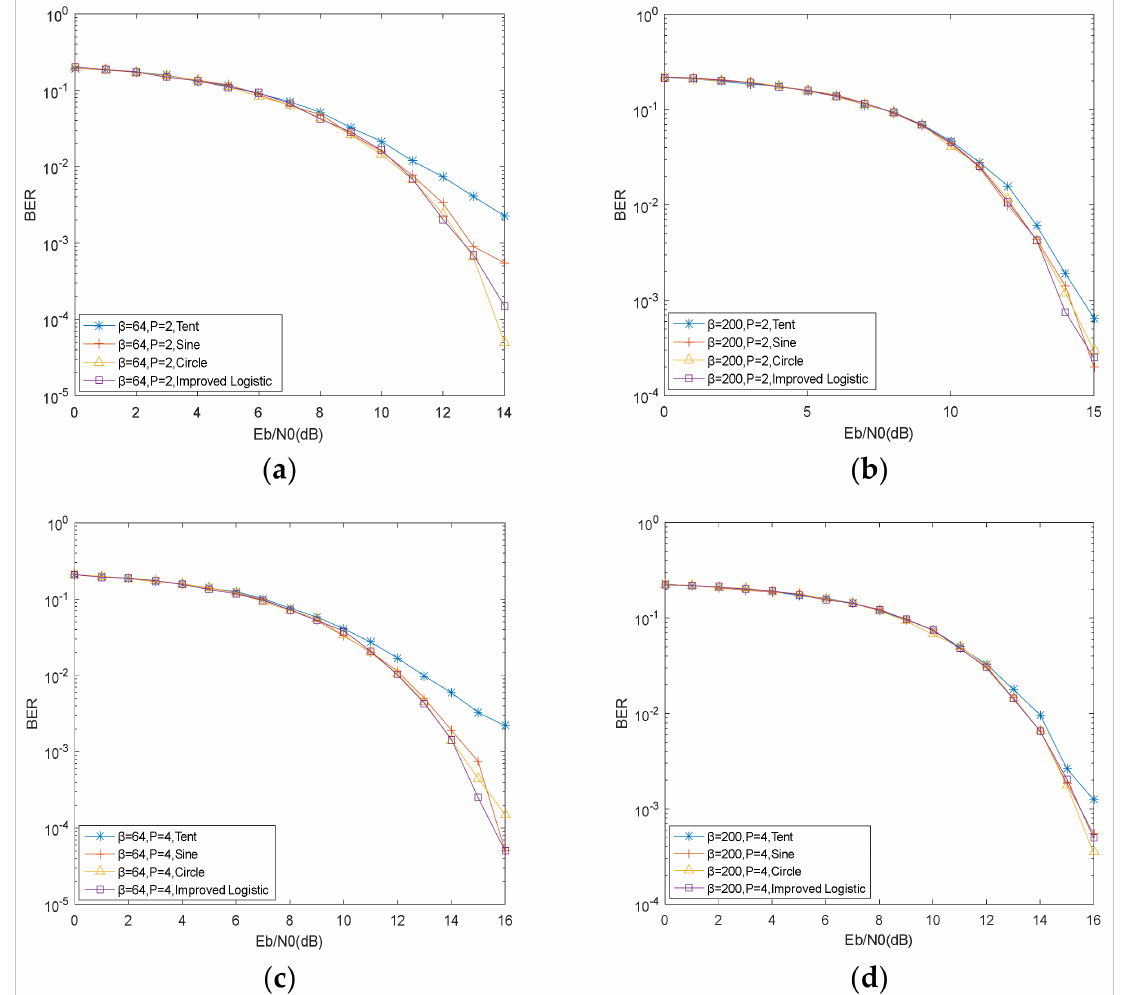
Figure 7. Effects of different chaotic maps on system performance ( a ) β = 64, P = 2, x ( 1 ) = 0.6; ( b ) β = 200, P = 2, x ( 1 ) = 0.6; ( c ) β = 64, P = 4, x ( 1 ) = 0.6; ( d ) β = 200, P = 2, x ( 1 ) =